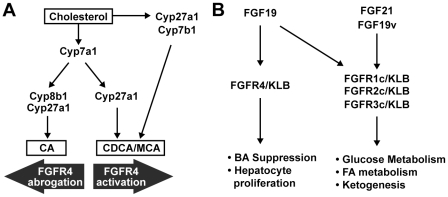
Models for metabolic pathways regulated by FGF19, FGF19v and FGF21.(A) Schematic diagram showing hepatic biosynthetic pathways that convert cholesterol into bile acids. The classical (neutral) pathway (center) is initiated by Cyp7A1, whereas the alternate (acidic) pathway (right) is initiated by Cyp27a1 and Cyp7b1. According to our model, FGF19 suppresses the classical pathway through transcriptional regulation of Cyp7a1 and Cyp8b1, shifting BA synthesis towards production of CDCA or its derivatives. (B) Distinct FGFR/KLB receptor complexes mediate various biological activities of FGF19, FGF19v, and FGF21. In addition to the model depicted, FGF21 and FGF19 can also suppress Cyp7a1 expression acutely in FGFR4-independent manner (Fig. 3).